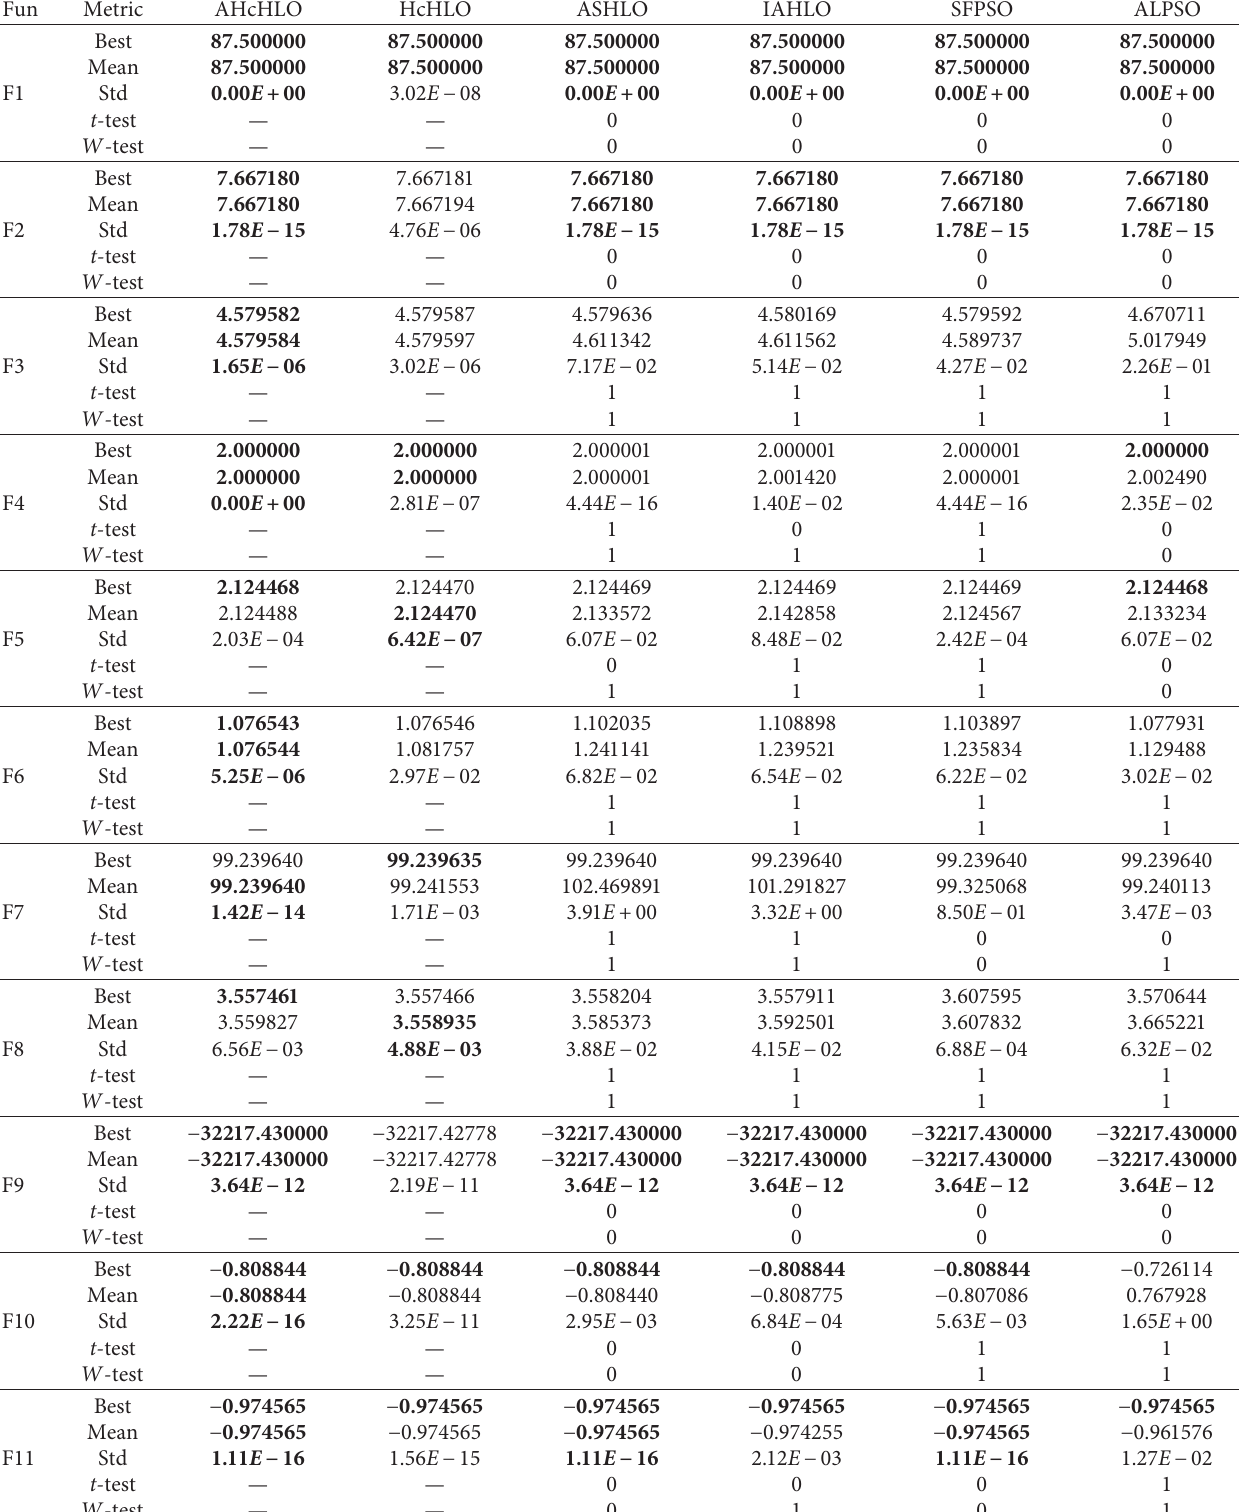
Table 1: Results of AHcHLO, HcHLO, ASHLO, IAHLO, SFPSO, and ALPSO on the benchmark